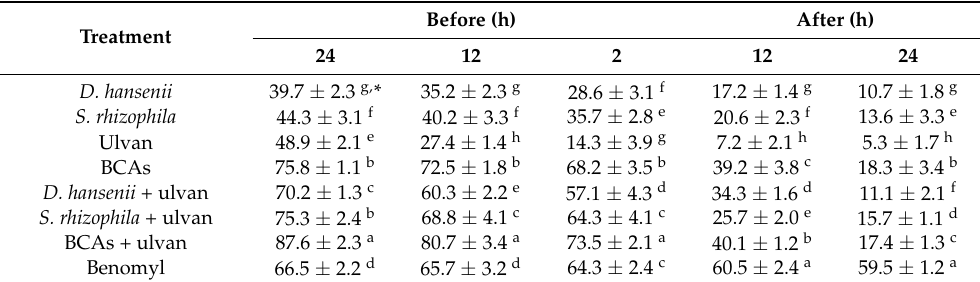
Table 2. Effect of inoculation timing of D. hansenii , S. rhizophila , and ulvan on disease control (%DC) by F. proliferatum on muskmelon fruit.